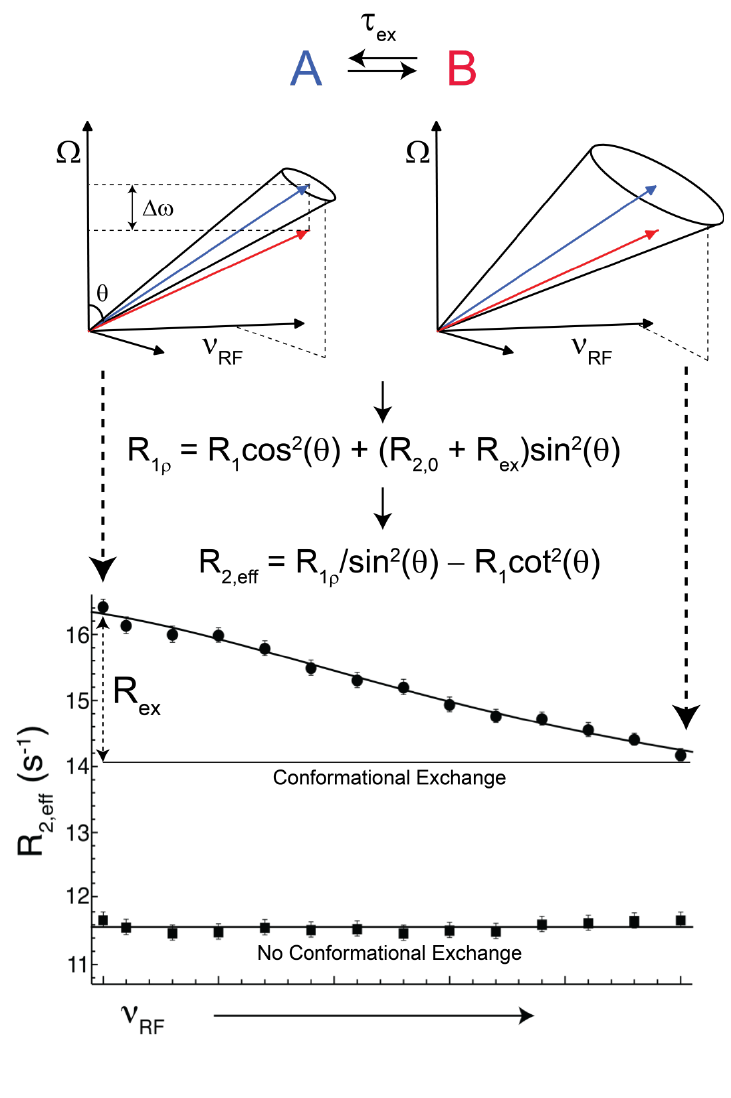
Figure 2. Illustrative schematic describing transverse rotating frame experiments (R ) for 1  the measurement of two-state conformational exchange events for NMR active nuclei. As states A and B interconvert with some lifetime (τ ) they have a phase separation of  . ex The length of each vector (arrow tipped lines) denotes the effective field that each populated coherence possesses. The effective field, or length of each vector, is governed by experimental parameters, namely the offset (  ) and  , where  is the difference between RF the resonance frequency for a given nucleus and the frequency at which  is applied. The RF effective field can be calculated as (rad s −1 ). The incomplete refocusing of state B (vector diagram on the left) leads to a dephasing of the magnetization, which translates to a larger relaxation rate. Upon sufficient refocusing of both magnetization vectors (vector diagram on the right) the relaxation rate decreases to R . The cones directly reflect the size of the nutation generated from the applied spin-lock 2,0 field. In the fast regime, the dependence of R with an increasing  gives a Lorentzian 2,eff RF profile [Equation (44)]. If no conformational exchange exists, then R remains constant 2,eff for all applied  RF